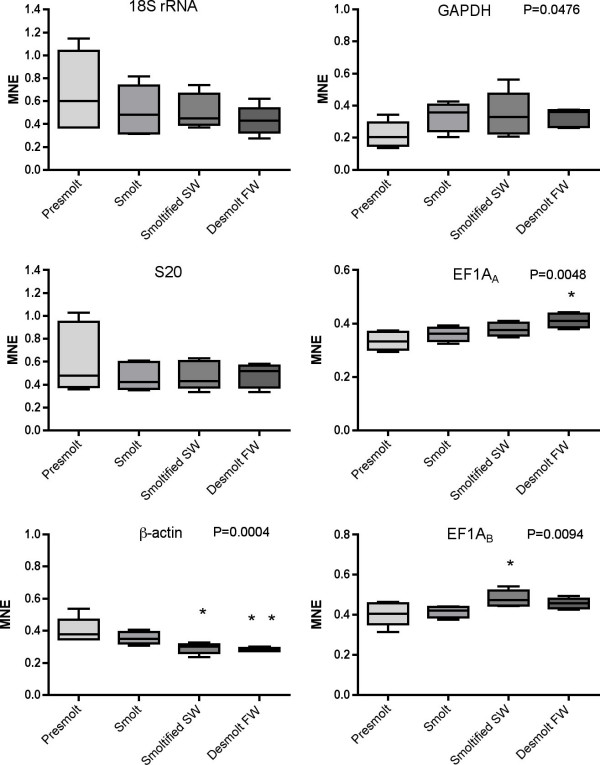
qRT-PCR analysis of six genes in gills of six smoltifying Atlantic salmon. The same data as in Figure 1, but now normalized against an index of the three best genes (β-actin, EF1AA and EF1AB) calculated with the geNorm software. The four groups were analyzed with Kruskal-Wallis test, and if significant, the overall p-value is given in the graphs. For β-actin, there were significant differences between the presmolt and the smoltified group (p < 0.05), the presmolt and the desmolt groups (n<0.01) and between the smolt and desmolt groups (p < 0.05). For EF1AA, there was a significant difference between the presmolt and the desmolt groups (p < 0.01). For EF1AB, there was a significant difference between the smolt and the smoltified groups (p < 0.05). An asterisk denotes significant differences between the groups.